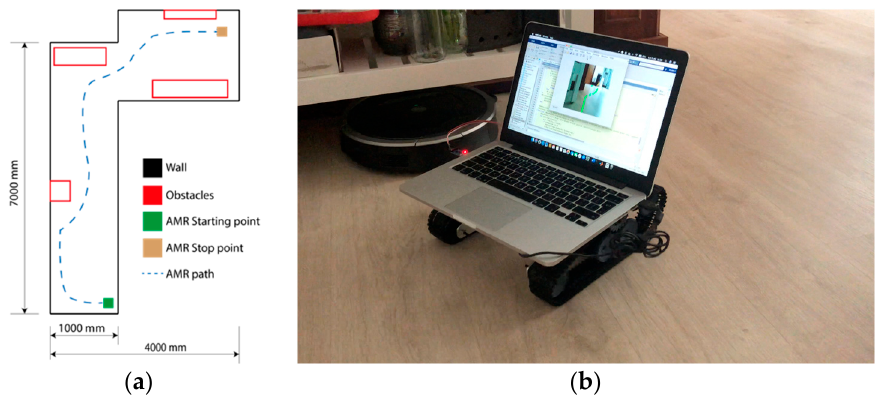
Figure 13. The Autonomous Mobile Robot’s stop position after the safety function activates: ( a ) Illustration; ( b ) real situation.